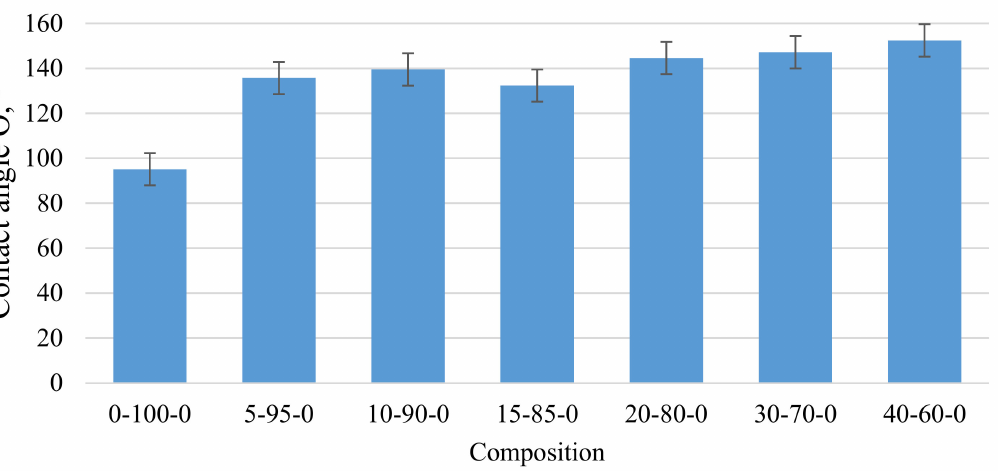
Figure 3. Variation of the wetting angle of the biocomposite depending on the amount of CR in the composite.